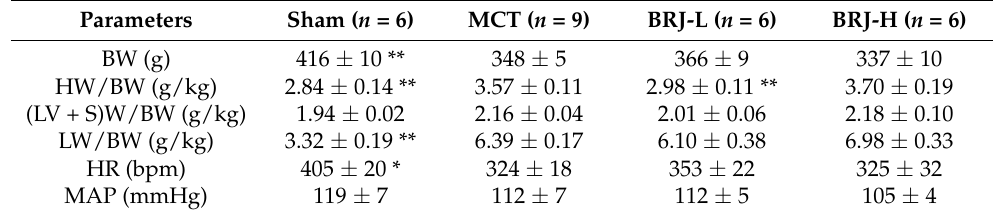
Table 1. Morphological and hemodynamic parameters.